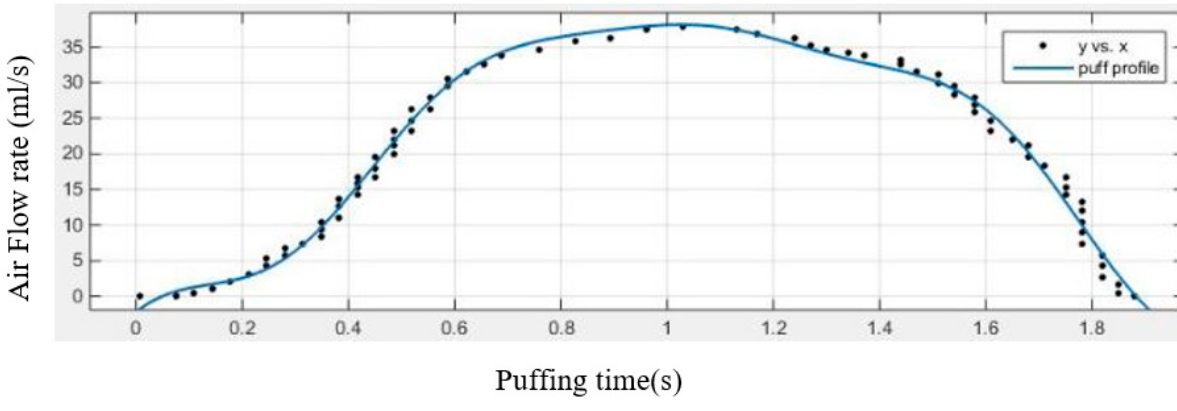
Figure 3. Inlet flow rate during puffing of cigarette.